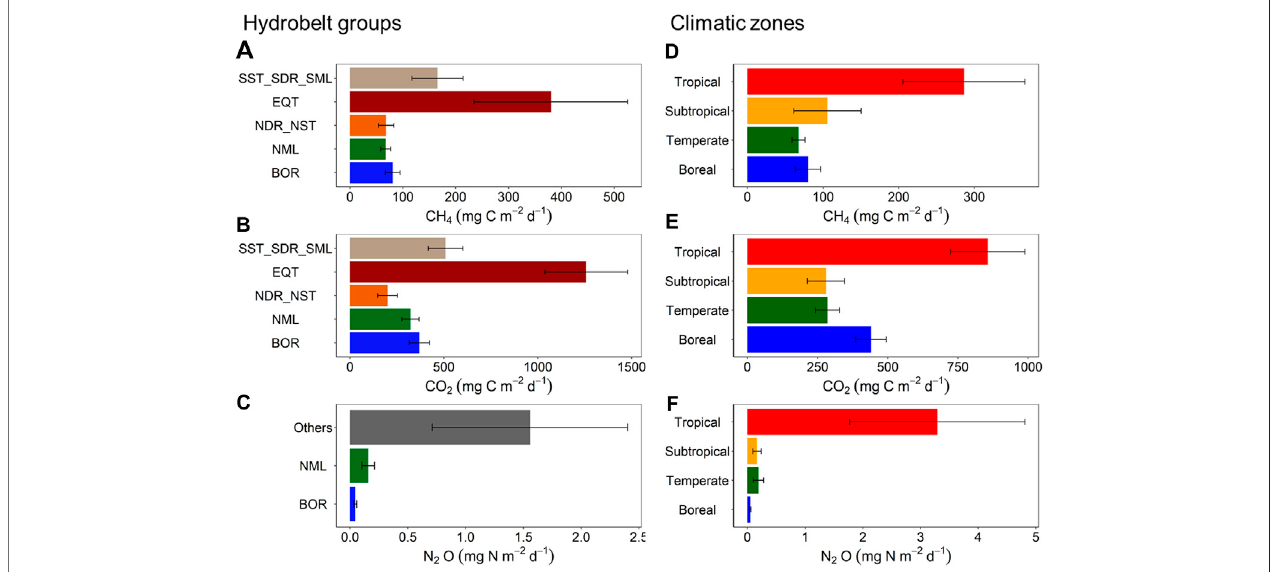
FIGURE 3 | GHG fl uxes from reservoirs for different hydrobelt groups (A,B,C) and climatic zones (D,E,F) for CH 4 , CO 2 , and N 2 O (from top to bottom) . For the hydrobelt classi fi cation, SST_SDR_SML is the combination of GHG fl uxes in the SST (south subtropical), SDR (south dry), and SML belts (south mid-latitude); EQT (equatorial belt); NDR_NST (north dry and north subtropical); NML (north mid-latitude) and BOR (boreal